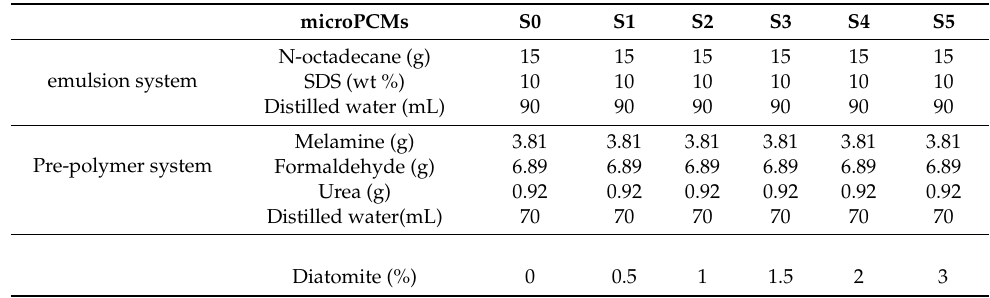
Table 1. Preparation of phase-change microcapsules (microPCMs) with melamine-urea-formaldehyde (MUF)/diatomite hybrid